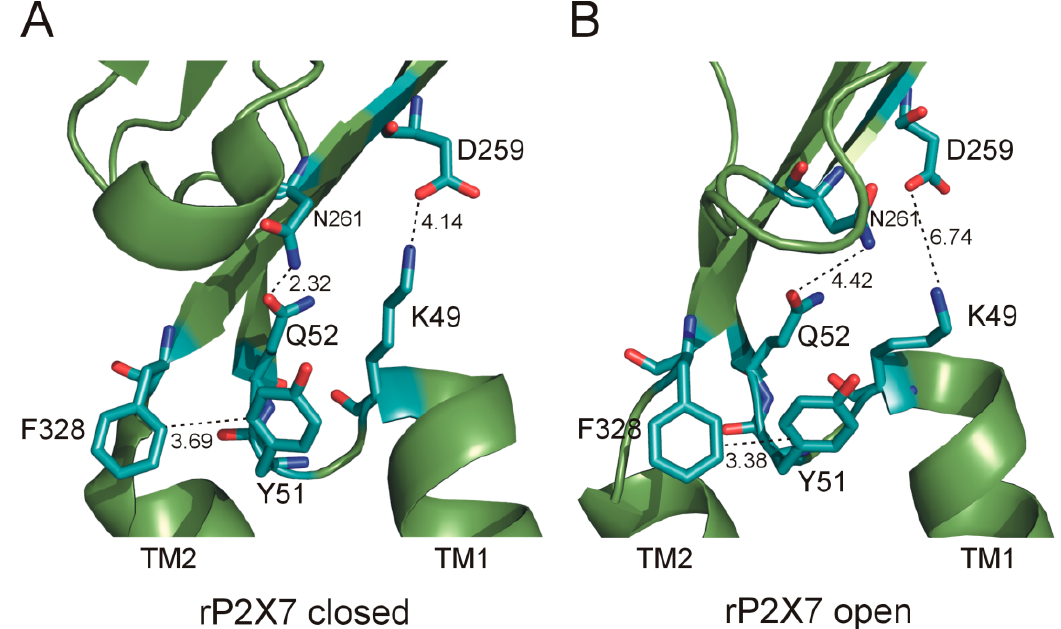
Figure 6. The possible interactions of K49, Y51, and Q52 with other residues in the same rP2X7 subunit. ( A ) Residue K49 can form an electrostatic interaction with D259 (4.14 Å), Y51 can form stacking interactions with F328 (3.69 Å), and Q52 can form an electrostatic interaction with N261 (2.32 Å) in the apo-closed state of rP2X7. ( B ) The interactions of K49–D259 and Q52–N261 are weaker, while the stacking interaction of Y51–F328 is stable in the ATP-bound open state of the rP2X7 channel. The model represents the rP2X7 receptor in the closed (PDB ID: 6U9V) and open (PDB ID: 6U9W) states [31]. This figure was generated using PyMOL v0.99 (http: // www.pymol.org). Side chains are represented as sticks, and all hydrogen atoms were omitted for clarity.